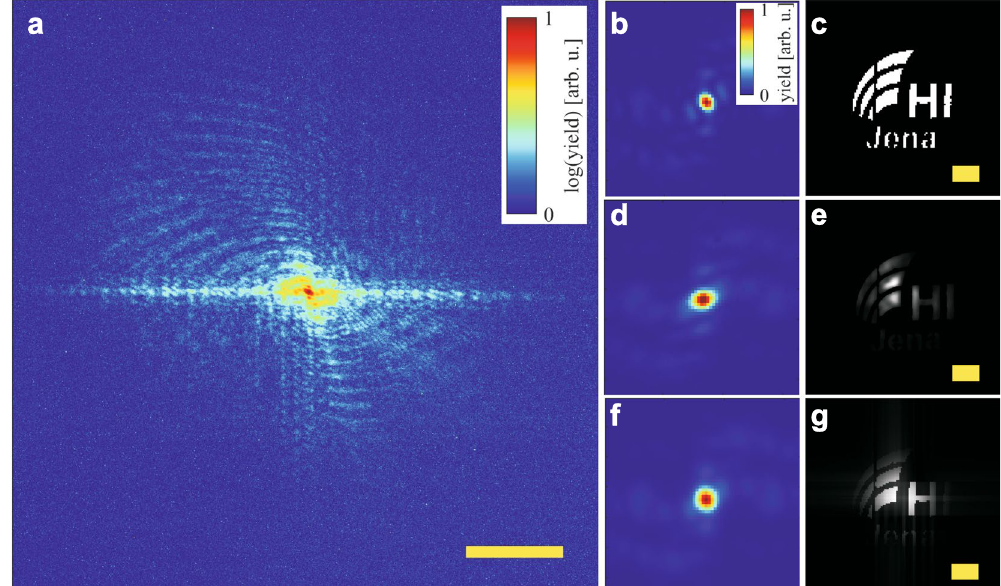
Figure 4. Coherent diffraction imaging using a solid-state SXRL. ( a ) Measured diffraction pattern captured from 300 laser shots featuring fringes extending well to the edge of the detector. ( b ) Comparing the modulus in Fourier space around the central speckle calculated from the STEM image of the sample ( c ) and comparing it to the measured data ( d ) one finds that it is best represented by convoluting the simulated pattern with a Gaussian having a width of 1.7 pixels ( f ) to account for the degree of decoherence. ( g ) The resulting simulation of the object space from the filtered Fourier space compares well to the reconstruction of the experimental data using established phase retrieval algorithms ( e ). The additional amplitude modulation in the retrieved object (Panel (e)) compared to the simulation ( g ) can be explained by the non-uniform wavefront of the SXRL focus (cf. far-field intensity distribution in Fig. 1b). See text for further discussion. Note that panel (a) is plotted using a logarithmic scale, while panels (b,d and f) are plotted on a linear scale. The scale bar in ( a ) is 10 µ m − 1 and those in ( c ), ( e ) and ( g ) are one